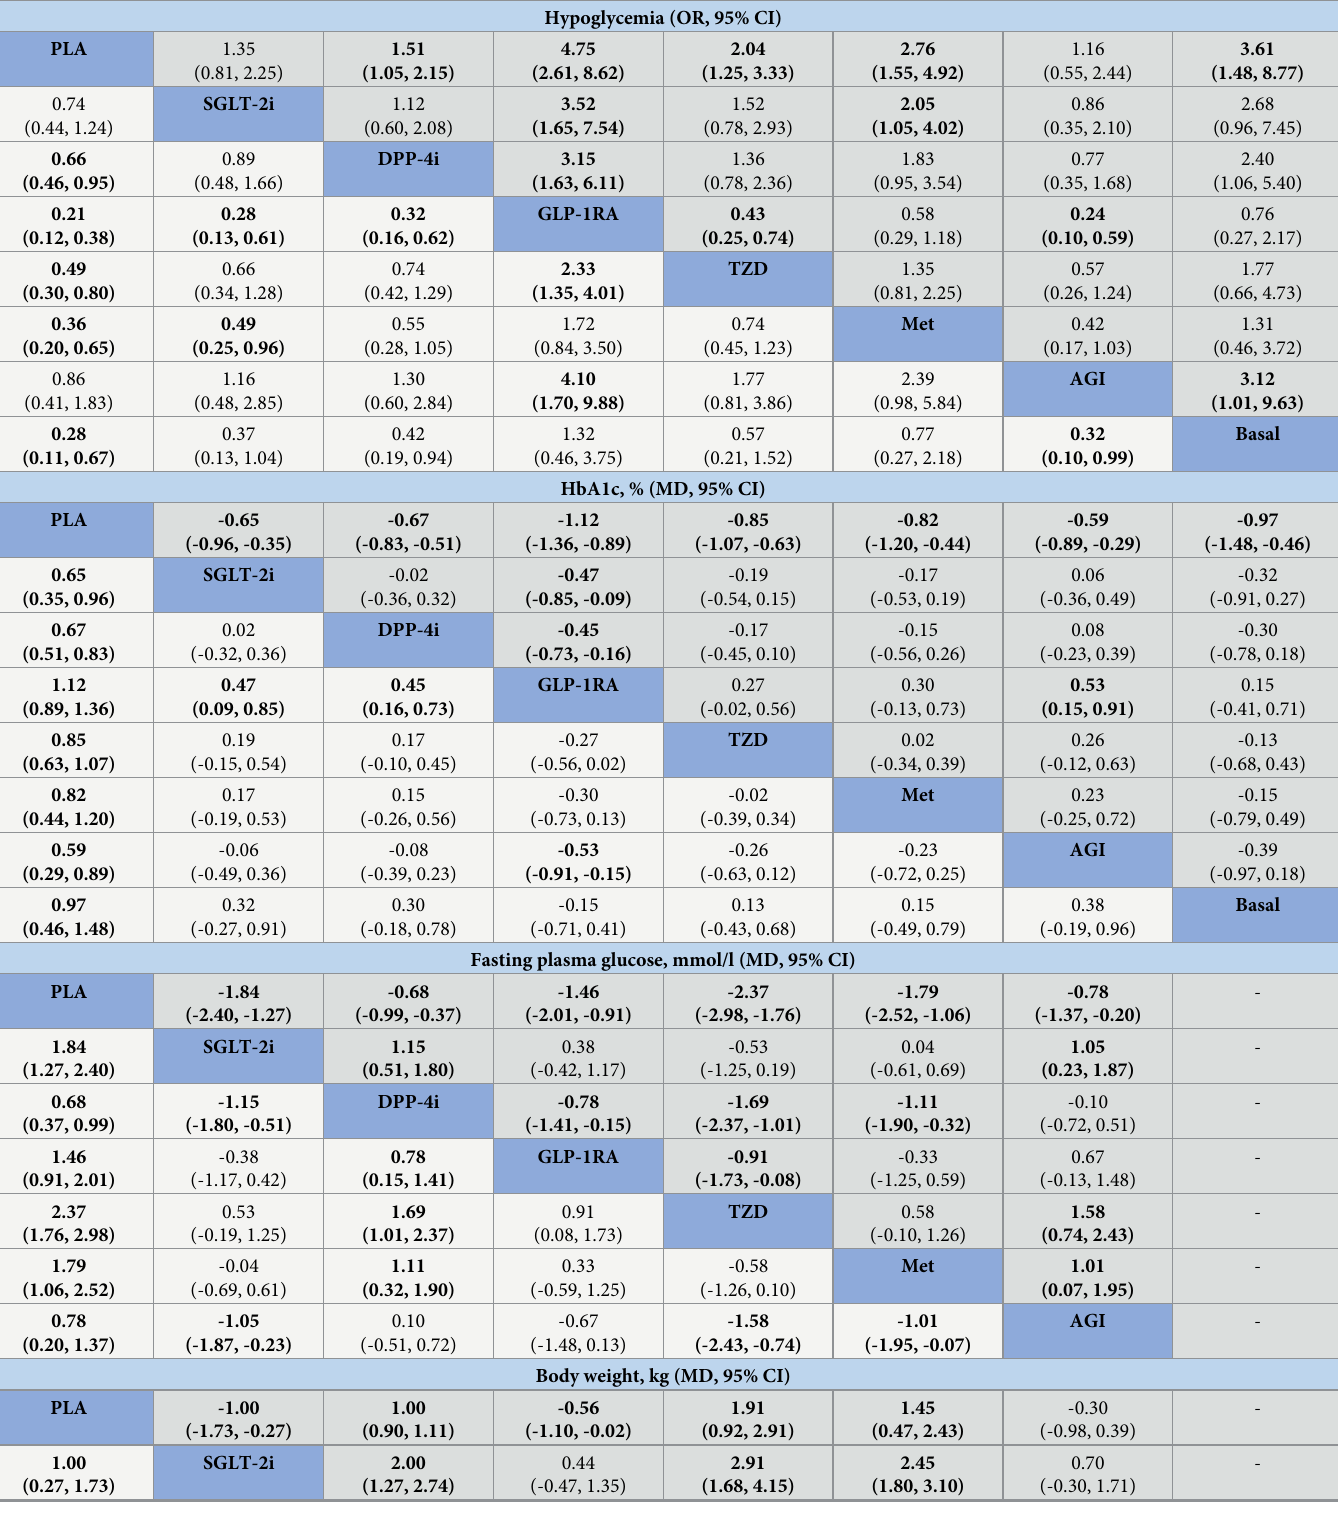
Table 2. Effect of glucose-lowering agents in patients with type 2